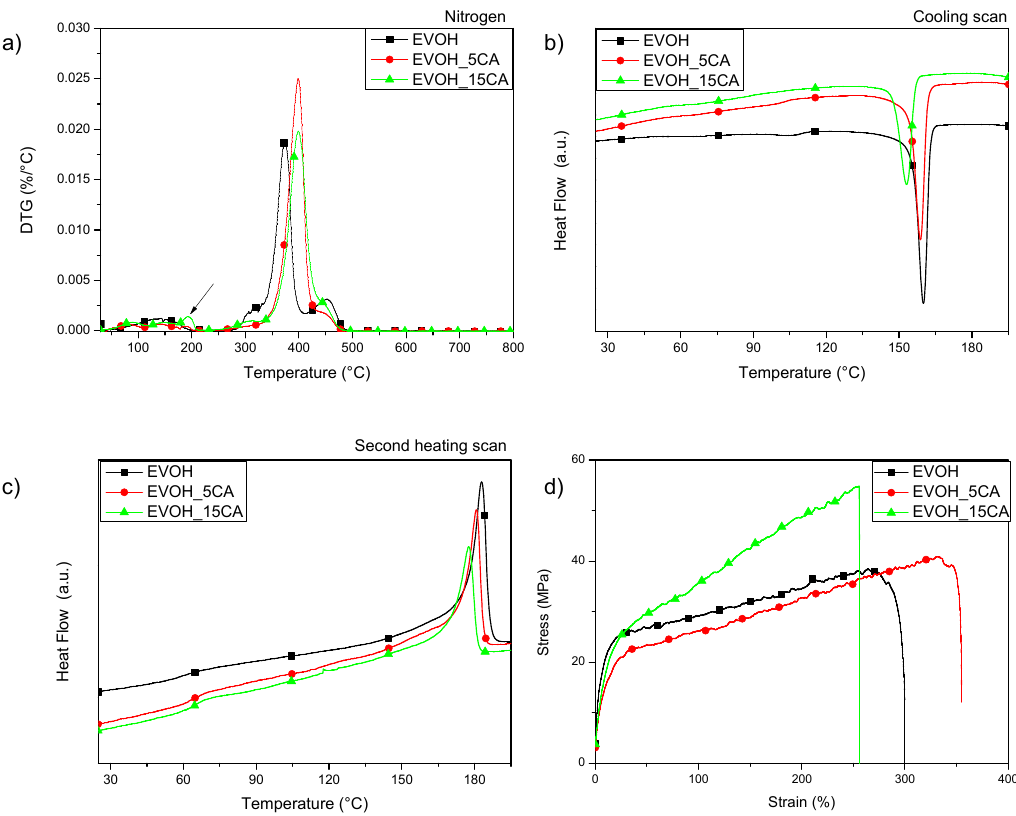
Figure 5. Derivative curves (DTG) ( a ), DSC thermograms cooling ( b ) and second heating scans ( c ) and stress–strain curves ( d ) of EVOH based formulations.